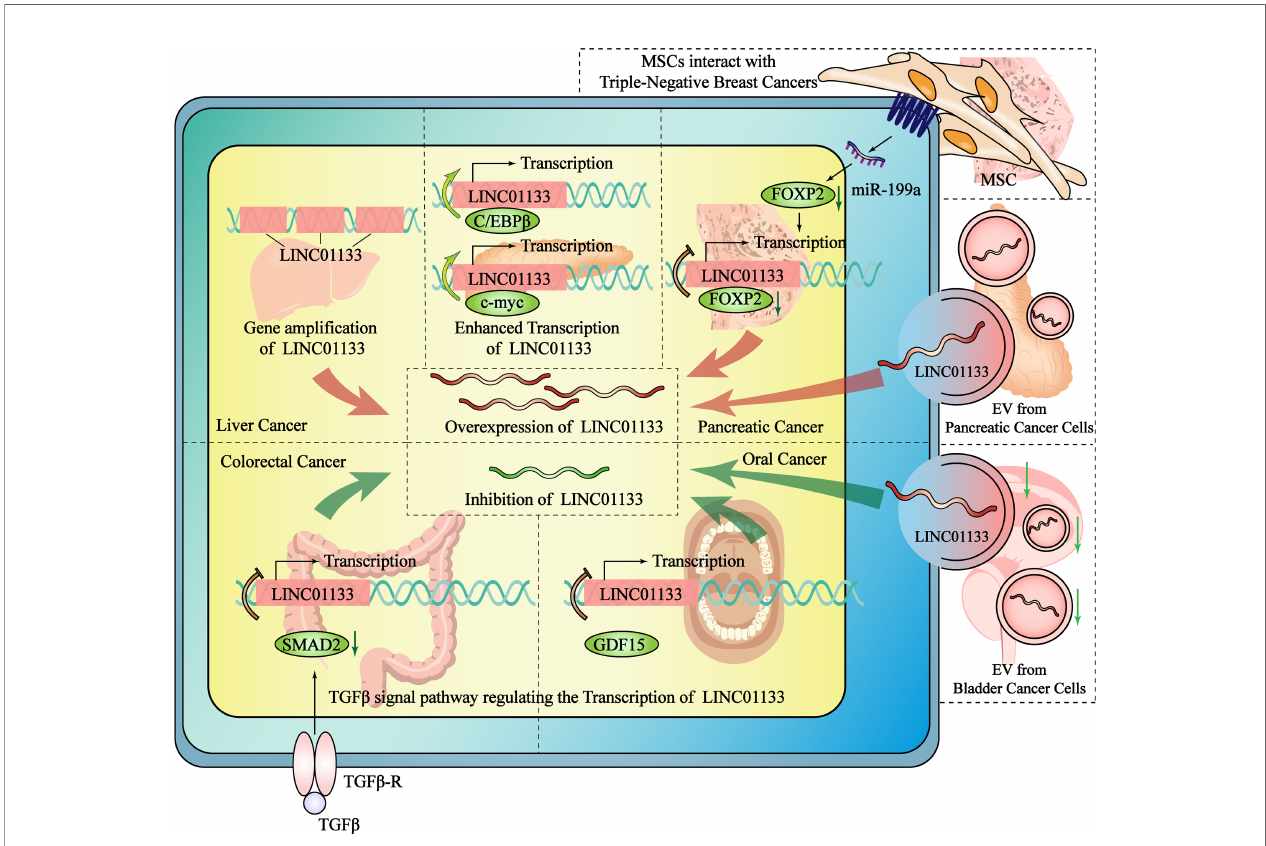
FIGURE 3 | The mechanisms regulate the expression of LINC01133 in the cancers of different tissue type. The overexpression of LINC01133 could be regulated by gene ampli fi cation of LINC01133, the enhanced transcription of LINC01133, the increased transport of LINC01133 by EVs and the promoting effect from MSC in TME. The inhibition of LINC01133 could be regulated by the TGF- b pathway. GDF15 belongs to TGF- b subfamily and also inhibit LINC01133 transcription. Compared with normal tissue cells, the number of LINC01133-containing exosomes secreted and received by cancer cells is reduced, which is one of the reasons why the concentration of LINC01133 in tumor cells decreases. The red arrow indicates the mechanisms that promote the expression of LINC01133, while the green arrow indicates the mechanisms that inhibit it. The black dashed lines separate different studies of the mechanisms that regulate the expression of